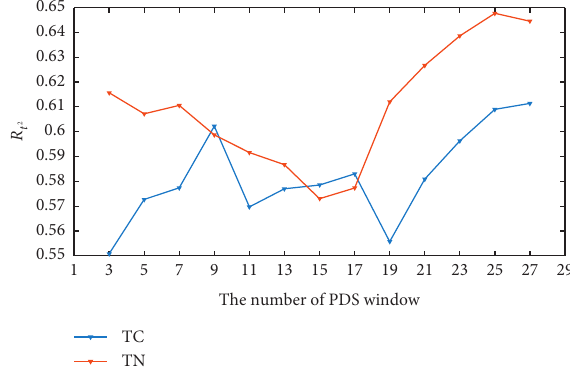
Figure 3: R 2 t of soil TC and TN concentration with different PDS window widths by Repfile-PDS. Table 4: Prediction results of TC and TN concentrations with different numbers of standard data by Repfile-PDS.